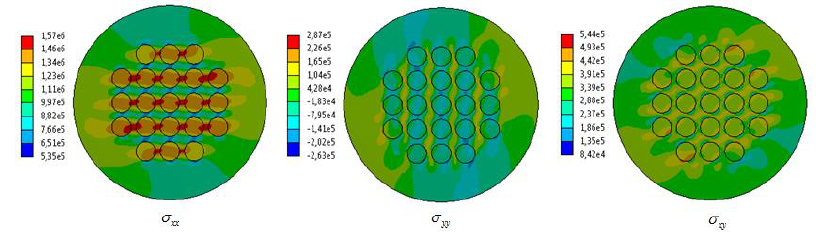
Fig. 11. Microstresses ( Pa ). The stress and strain fields are not uniform. The reactive forces are determined at the boundary of the region Ω (Fig. 12).